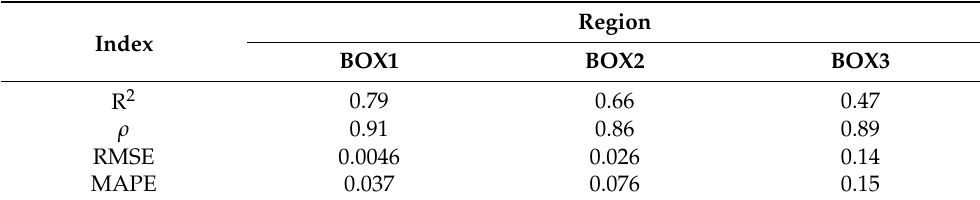
Table 5. Statistical results of the comparison between the observed Chl a values and the predicted Chl a concentrations by the IDNN models using remote-sensing data. R 2 refers to the determination coefficient, ρ to the Pearson’s correlation coefficient, RMSE denotes the root mean square error, and MAPE represents the mean absolute percentage error.